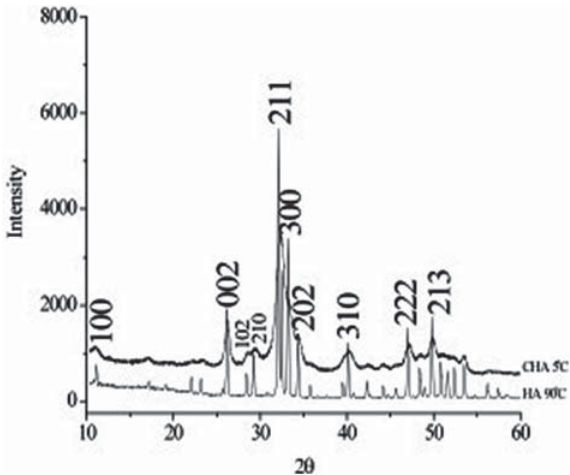
Figure 1- X-Ray Diffraction pattern (XRD) of the carbonated hydroxyapatite (CHA) powder. Observe broad peaks due to the nanostructured and poorly crystalline character of the